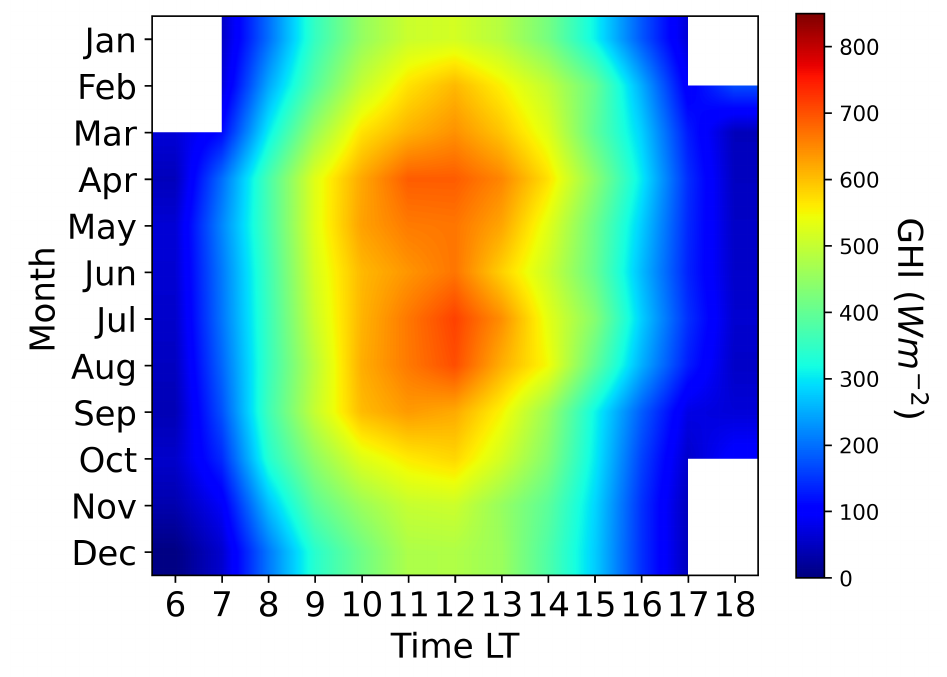
Figure 2. Monthly hourly averages (Wm − 2 ) section of the global solar irradiance (GHI) at Camagüey for the entire measured period